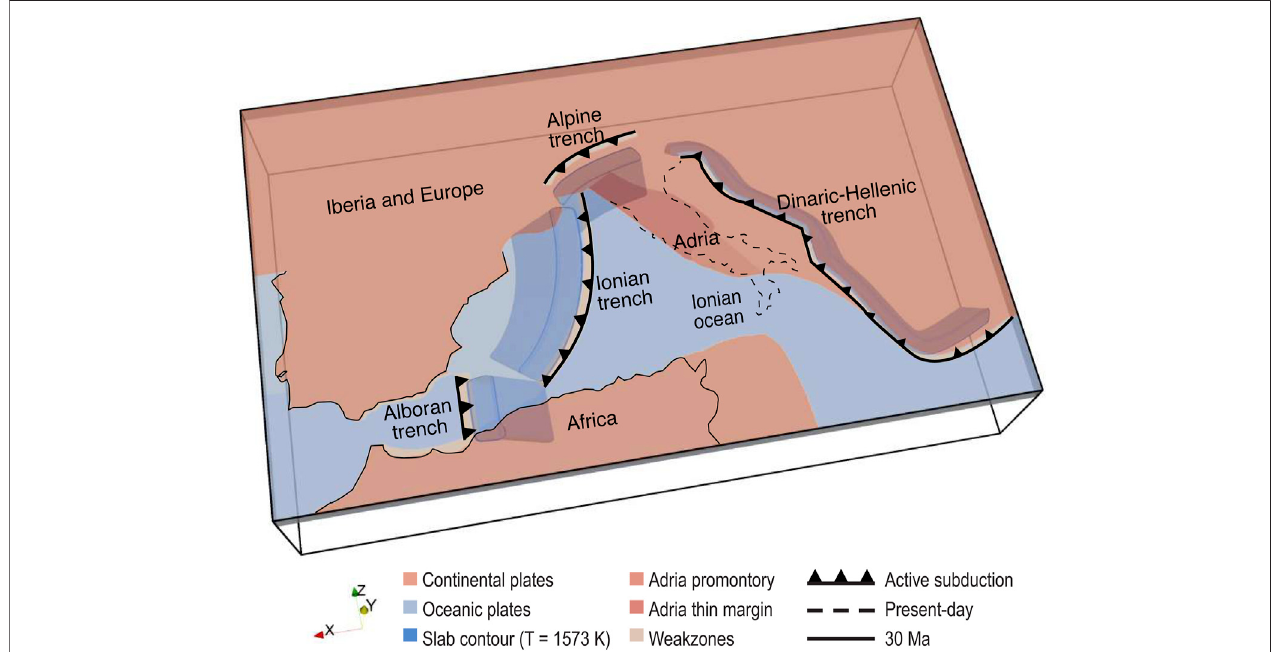
FIGURE 1 | Initial model setup for Model CWM. It consists of a subducting oceanic plate (Ionian Ocean; light blue) surrounded by lateral continental blocks (Adria, Africa, Iberia and Europe; salmon pink) drawn according to paleogeographic reconstructions at ~30 Ma proposed by Faccenna et al. (2014); van Hinsbergen et al. (2014); Romagny et al. (2020). The Adria plate is characterized by the presence of a stiffer continental promontory (peach pink) and a thin continental margin (red) as proposed by Lucente and Speranza (2001); Lucente et al. (2006); Lo Bue et al. (2021). Multiple subducting slabs are positioned according to the chosen reconstructions (i.e., Alboran and Ionian trenches as in Romagny et al. (2020); Alpine and Dinaric-Hellenic trenches as in Faccenna et al. (2014)) and taking into account the limitations imposed by numerical modeling. The solid black line indicates the coastlines at ~30 Ma as in van Hinsbergen et al. (2014), while the dashed black line the present-day coastlines of peninsular Italy. The plates are opaci fi ed for a better visualization of the subducted slab.